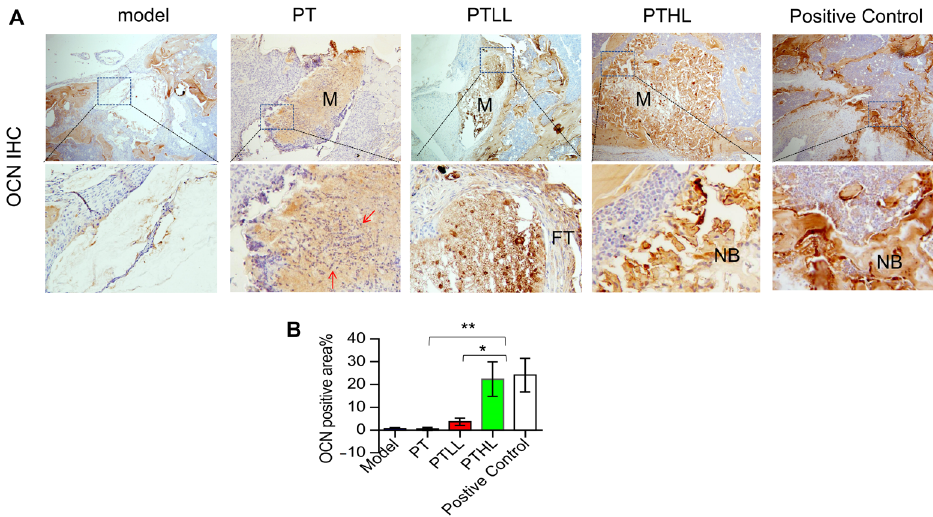
Figure 5. OCN expression in rat femoral defect models. ( A ) Histological images of OCN IHC staining in infected femoral defects (red arrow: bacteria; M: implanted material; FT: fibrous tissue; NB: new bone tissue). ( B ) The percentage of OCN-positive area in IHC image of each group. Student’s t -test, mean ± sd, * p < 0.05, ** p < 0.01.